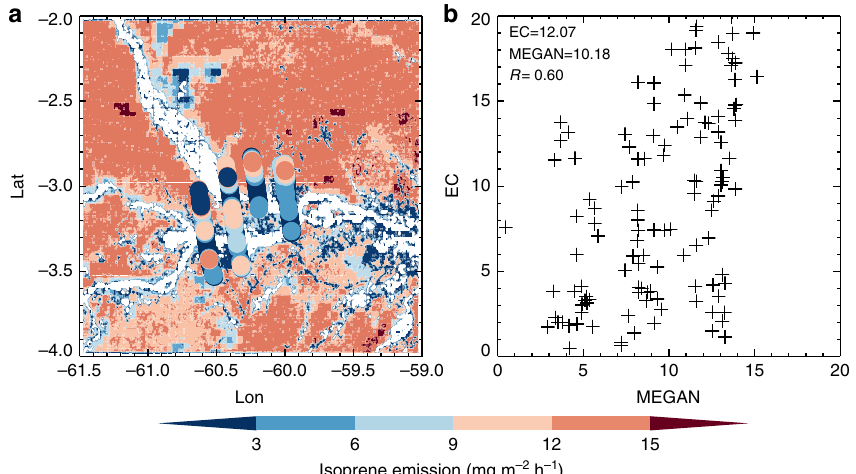
Figure 2 | Surface isoprene emission flux during flight RF 20140930. ( a ) Spatial distributions from airborne EC method (solid circles) compared with MEGAN simulations (background colours); ( b ) scatter plot of the EC and MEGAN estimates, and their mean values and linear correlation coefficient are shown in the